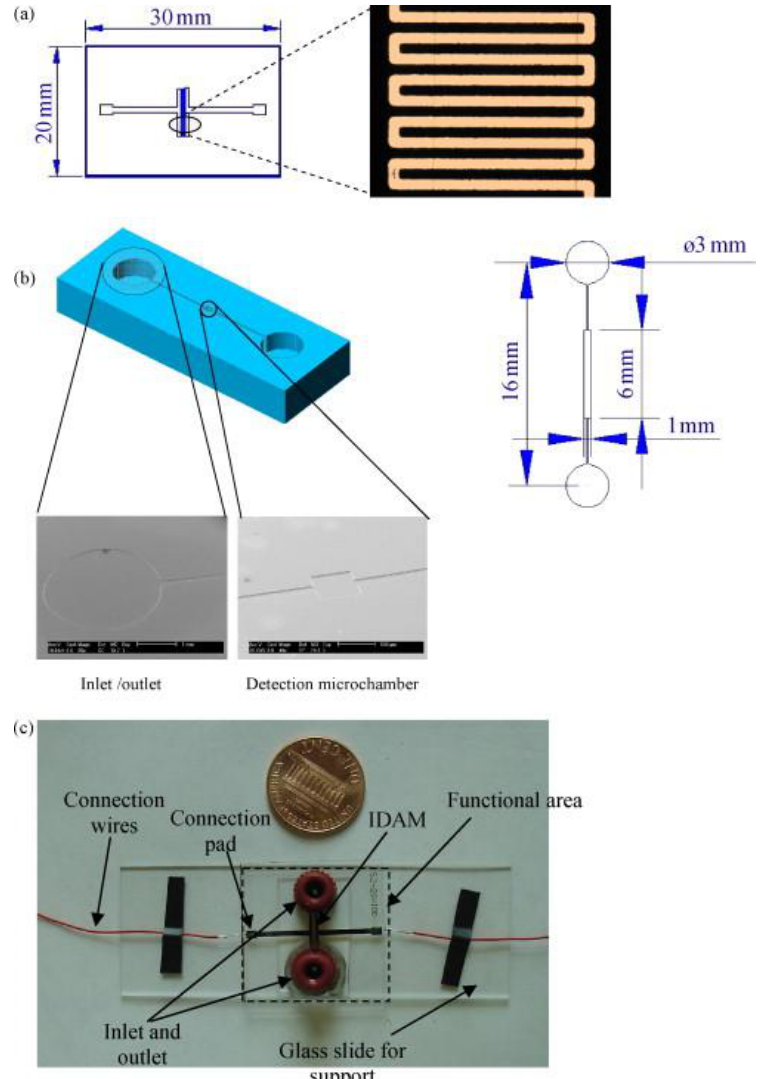
Figure 5. ( a ) IDAM chip with gold microelectrodes on a glass wafer, ( b ) a microchannel with a detection microchamber, and inlet and outlet channels, and ( c ) an assembled microfluidic flow cell with embedded IDAM and connection wires